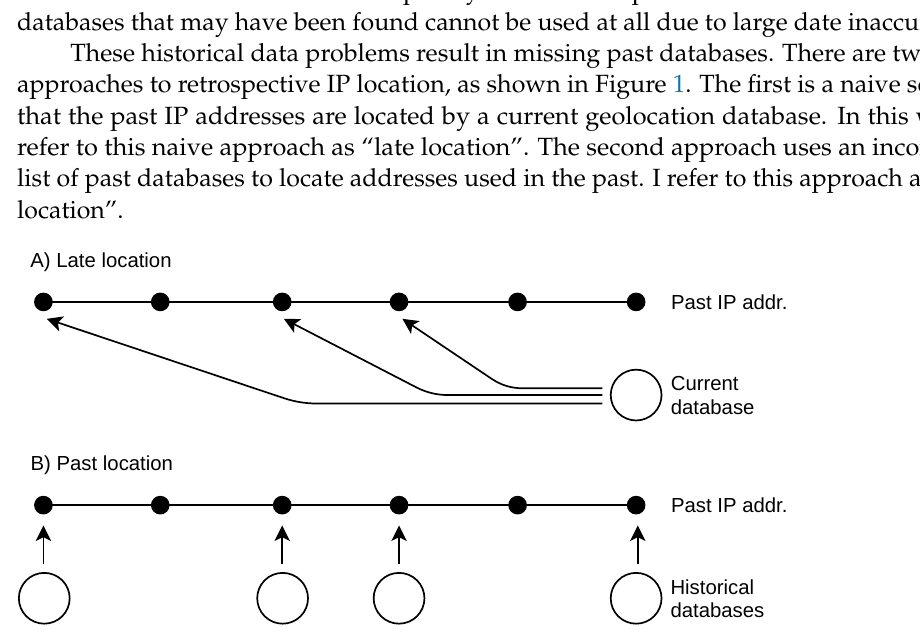
Figure 1. Approaches to retrospective IP geolocation due to missing past databases. ( A ) Naive approach with the current database used. ( B ) Past approach with a limited set of past databases used. The past databases should be close to the date of the past IP address